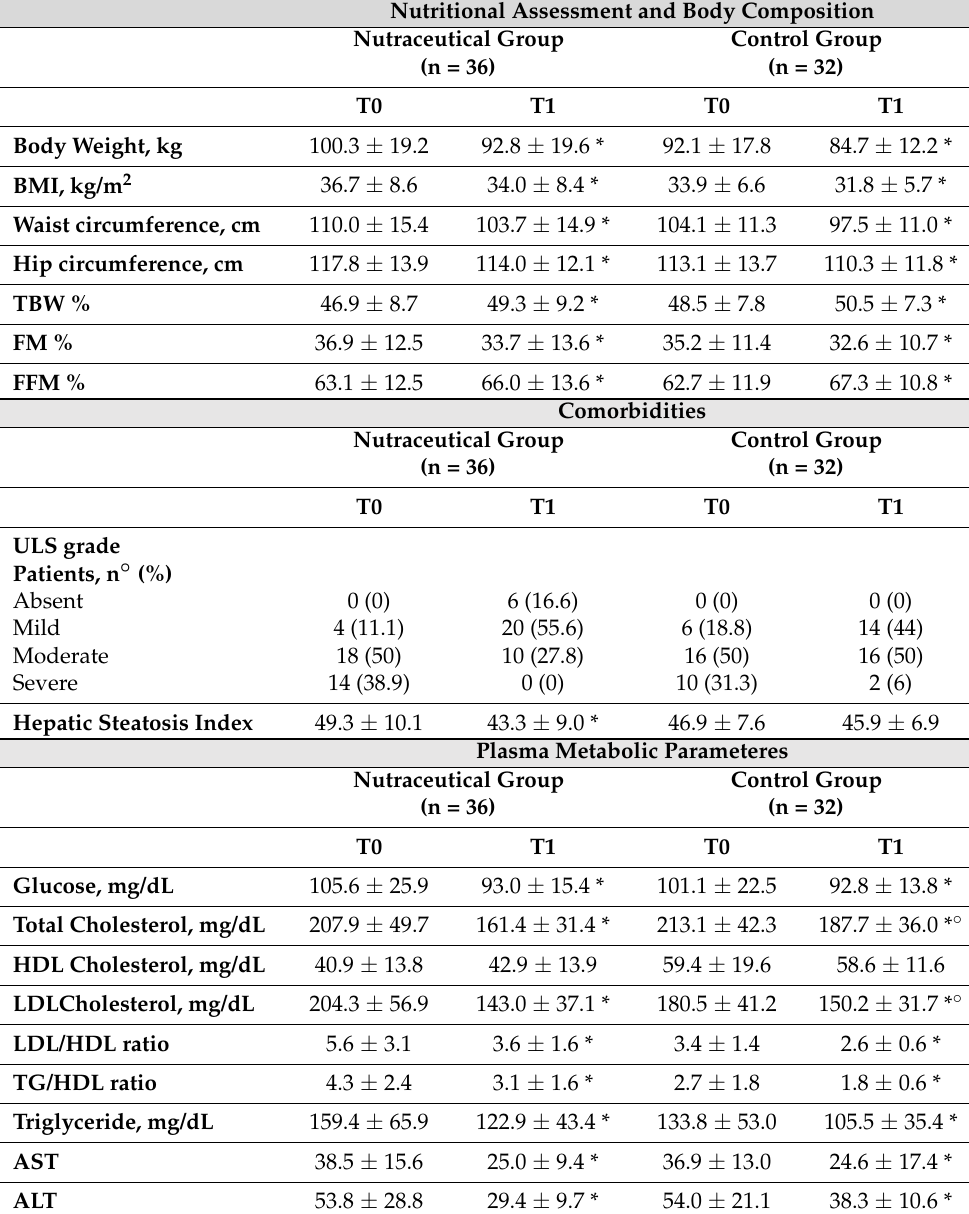
Table 3. Anthropometric measurements as well as liver steatosis grade, biochemical parameters, body composition and hepatic steatosis index at baseline and after 3 months of treatment. Data